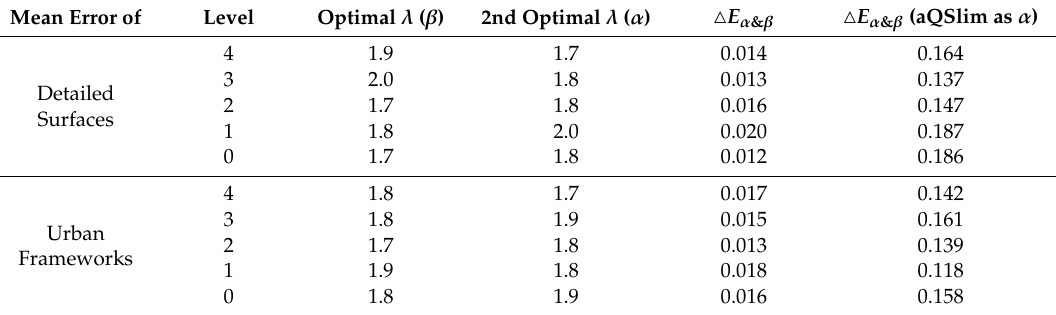
Table 2. Optimal choice of curvature indicator of mDVDC for tile B.